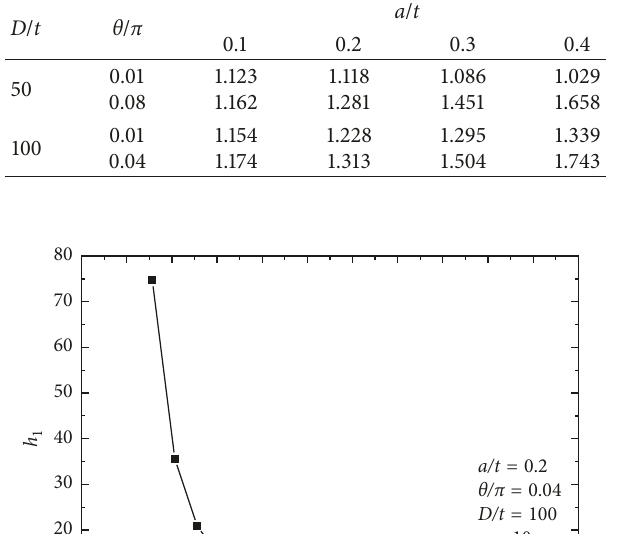
Table 4: Tabulated values of h